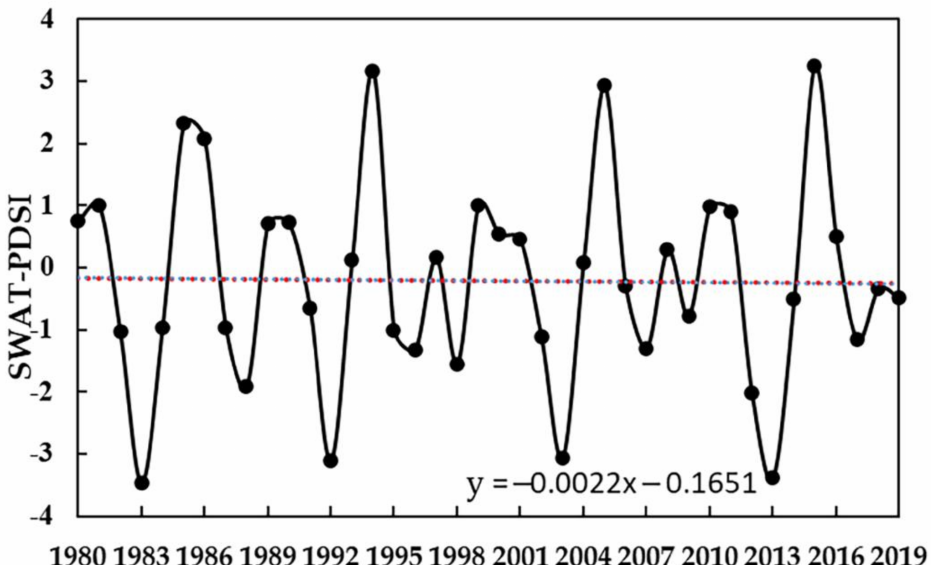
Figure 3. Temporal variation in the annual average SWAT–PDSI values in the Yihe River Basin from 1980 to